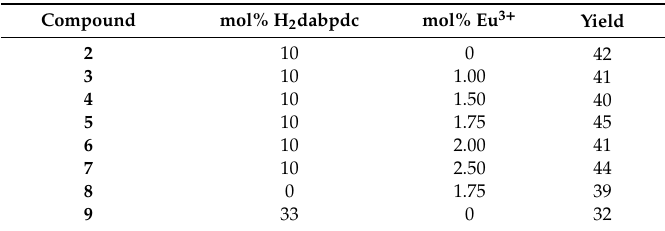
Table 1. Percentages of H 2 dabpdc and Eu 3 + doping 1 and